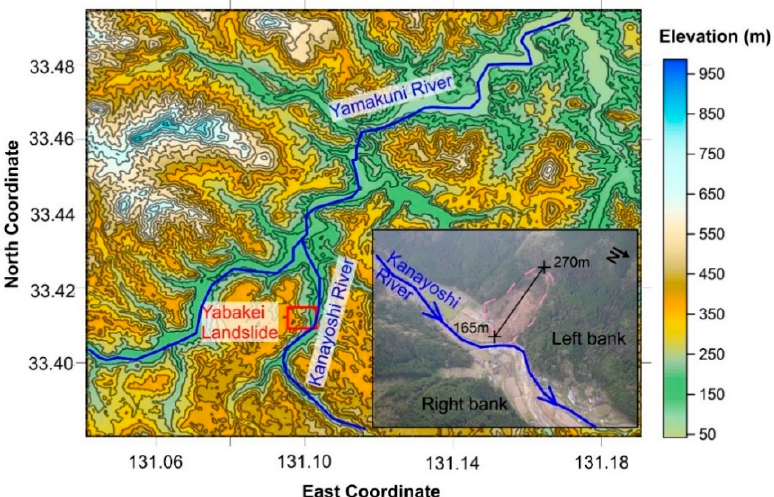
Figure 4. Altitude of the Yabakei landslide area.